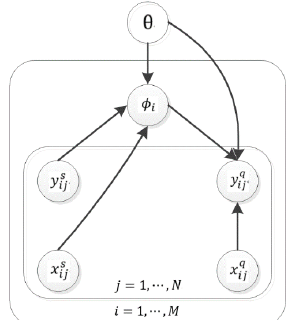
Figure 1. The graphical model for the meta-learning framework. Open circles represent one or a group of random variables. The arrows indicate probabilistic dependencies between random variables.